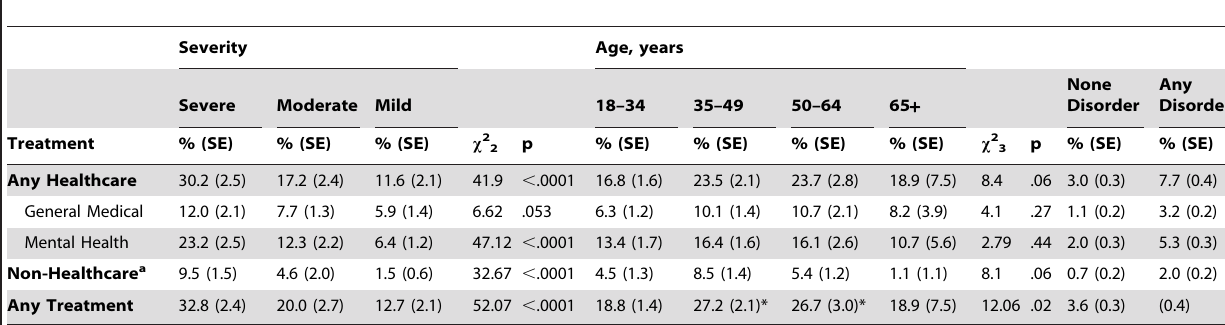
Table 5. Association of 12-month DSM-IV/WMH-CIDI disorder severity and age cohorts with treatment type.